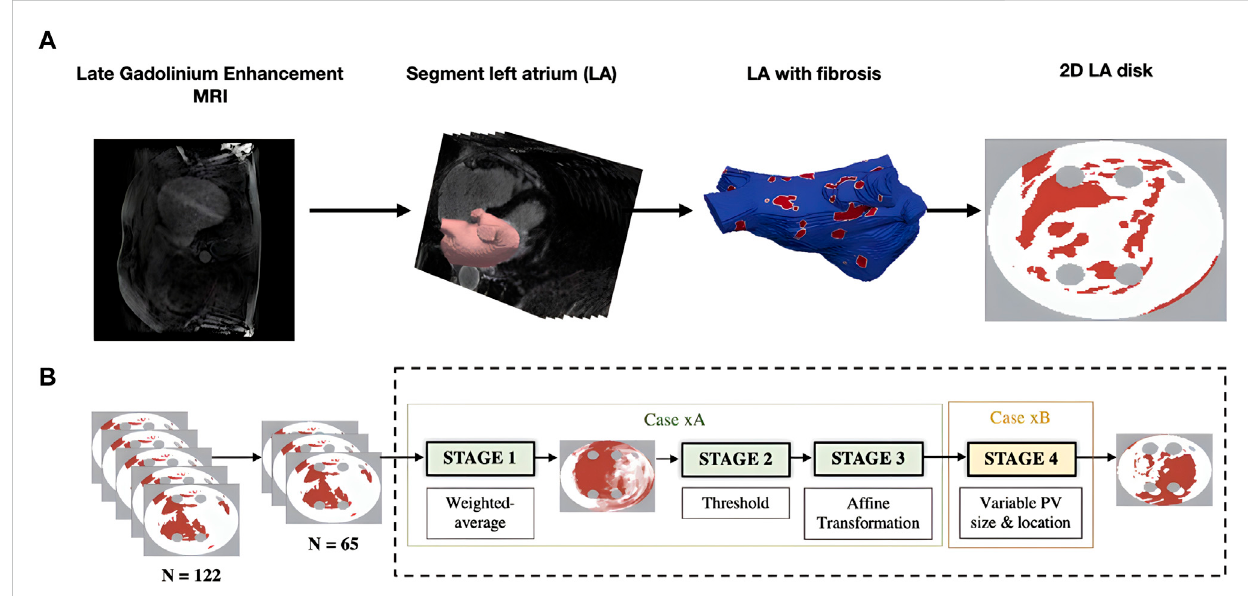
FIGURE 1 DiagramofMRI-derived2DLAtissuedisk. (A) .Work fl owof2DLAtissuegenerationpipeline.The fi gureillustratestheprocessofhowthe2DLAtissue models are obtained from LGE MRI by LA segmentation, thresholding fi brosis from healthy tissue and mapping onto 2D LA tissues. (B) . Work fl ow for generating synthetic tissues. 65 tissues were randomly selected from the total dataset of 122 real tissues. These 65 tissues were used to generate the synthetic images by iterating overstages 1 to 4 (199 times) to create a virtual cohort of 199 tissues. ‘ Case xA ’ denotes the combination of data augmentation techniques used to create the synthetic fi brosis distributions. ‘ Case xB ’ determines how the PV sizes and locations were varied from those in the standardised